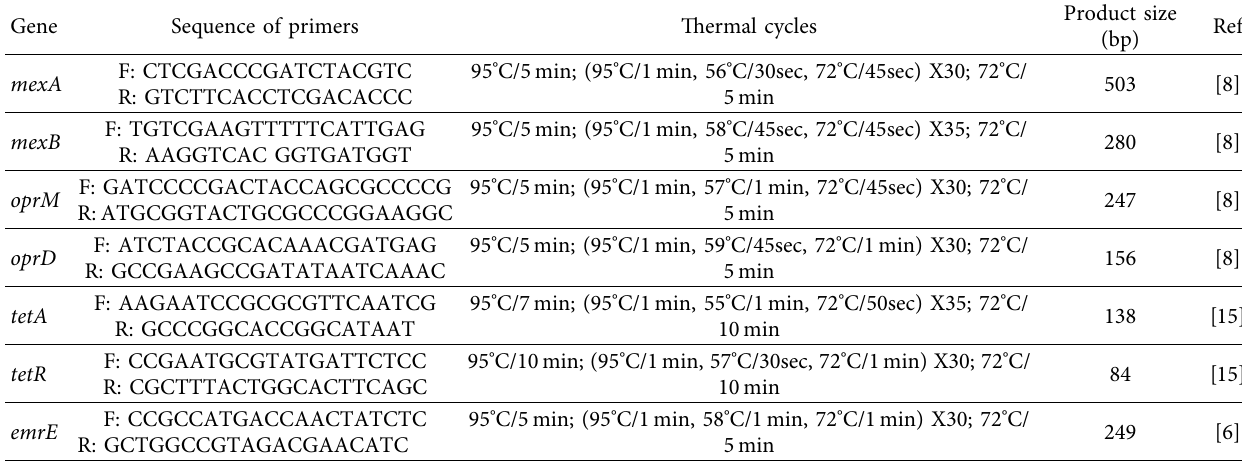
Table 1: Oligonucleotide sequences used in this study and thermal cycling conditions.